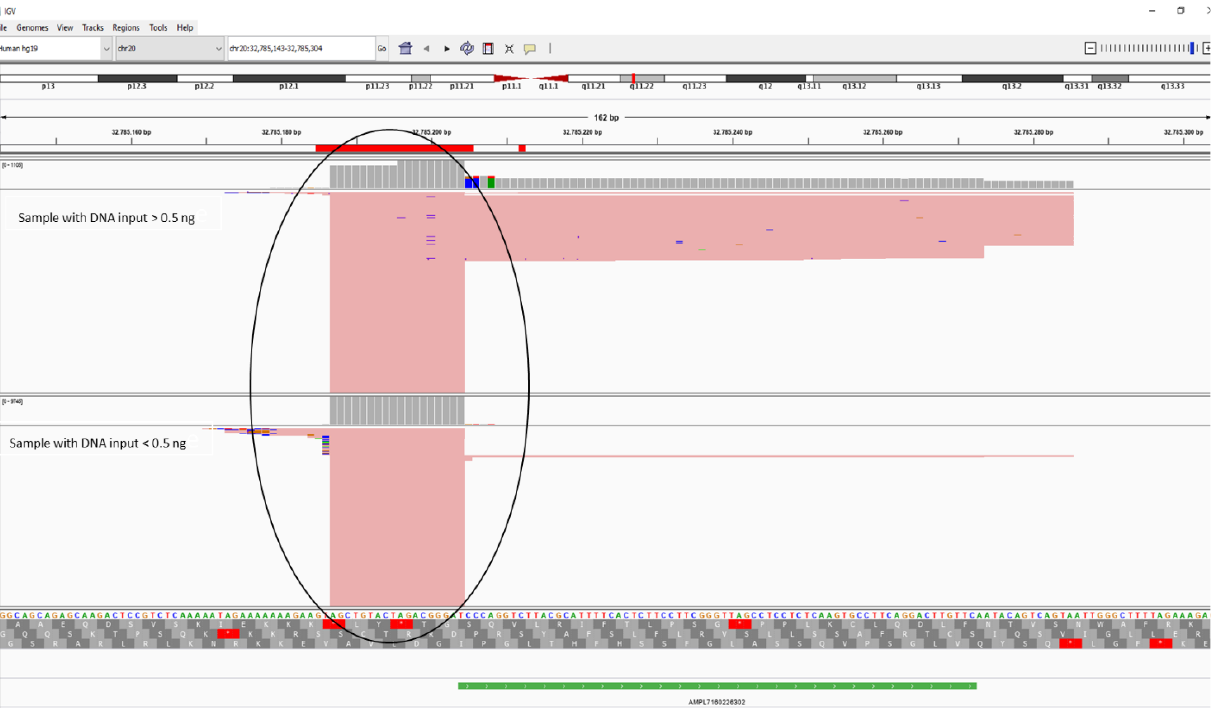
7 of 17 Figure 2. Comparison of average rDoC distribution observed in non-degraded samples (DNA input > 0.5 ng and DNA input < 0.5 ng) and DNA degraded samples. X -axis: mean relative depth of cov- erage (rDoC) value; Y -axis: polymorphisms included in the amplicons together with the amplicon